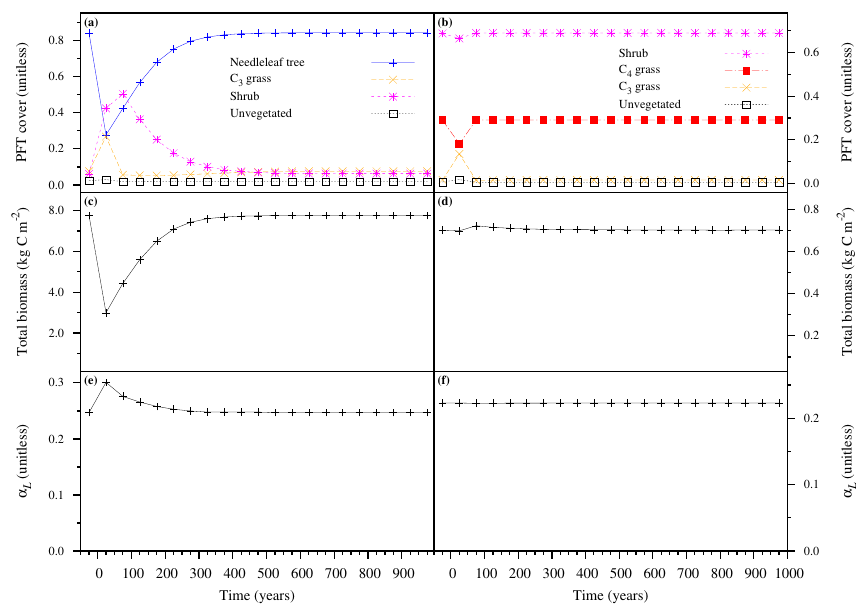
Figure 2. Changes due to the 200PgC fire pulse happening in year 0; each data point gives the mean value over 50years (25years before and 25years after). Results are for a forested grid cell in North America (centred on 53.1 ◦ N, 124.2 ◦ W; panels a , c , and e ) and a savanna grid cell in Africa (centred on 13.5 ◦ N, 12.6 ◦ E; panels b , d , and f ). (a, b) Fractional cover of the different plant functional types. (c, d) Total biomass. (e, f) Land surface